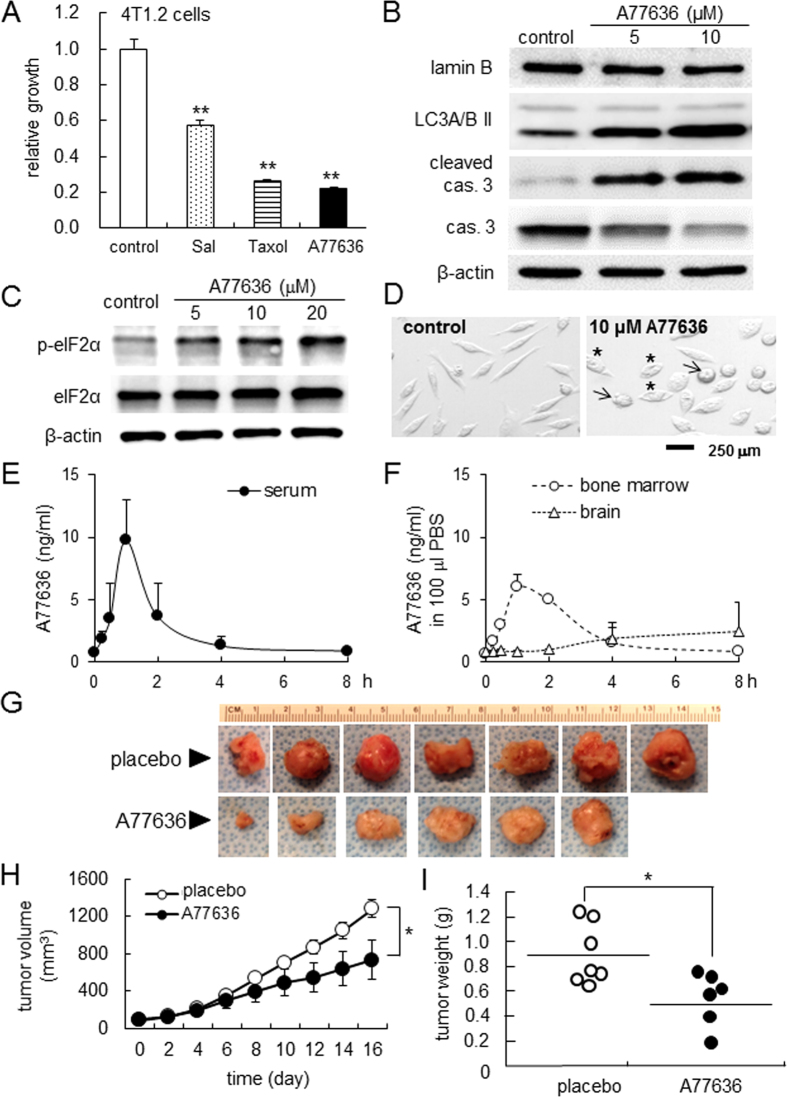
Suppression of tumor growth by A77636.The single and double asterisks indicate p < 0.05 and p < 0.01, respectively. (A) Reduced growth of 4T1.2 mammary tumor cells by 10 μM of Sal (salubrinal), Taxol, and A77636. Salubrinal is an inhibitor of PP1 phosphatase that de-phosphorylates eIF2α. (B) Expression of lamin B as a marker for integrity of nuclear envelopes, microtubule associated protein light chain 3 A/B II (LC3A/B II) as a marker for autophagy, and cleaved and uncleaved caspase 3 as a marker for apoptosis, in response to 5 and 10 μM A77636 in 4T1.2 cells. (C) Upregulation of eIF2α phosphorylation by A77636 in 4T1.2 cells. (D) Images of normal (control) and damaged (A77636-treated) 4T1.2 cells. The arrow and asterisk indicate apoptotic and autophagy cells, respectively. (E) Concentration of A77636 in the serum in response to i.p. injection of A77636 at a dose of 2 mg/kg. (F) Detection of A77636 in the bone marrow (femur), and brain (frontal cortex, ~60 mg) in response to i.p. injection of A77636 at a dose of 2 mg/kg. The femoral bone marrow and frontal cortex were dissolved in 100 μl PBS, and the concentration was measured. (G) Mammary tumors at the injected site of mammary fat pad for the placebo (N = 7) and A77636-treated mice (N = 6). (H,I) Volume (mm3) and weight (g) of mammary tumors.